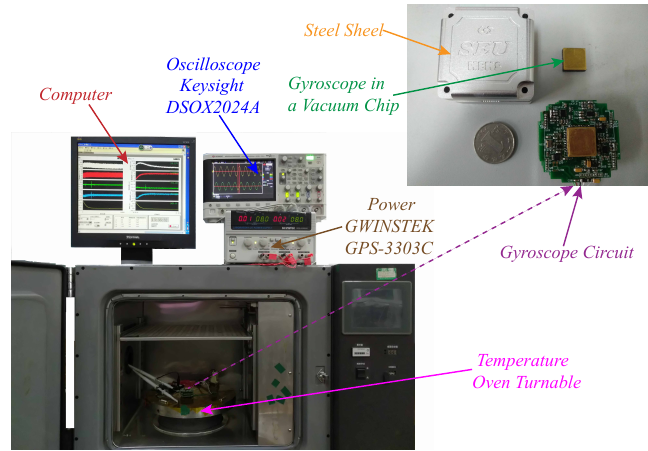
Figure 12. Photos of the MEMS gyroscope circuit and test